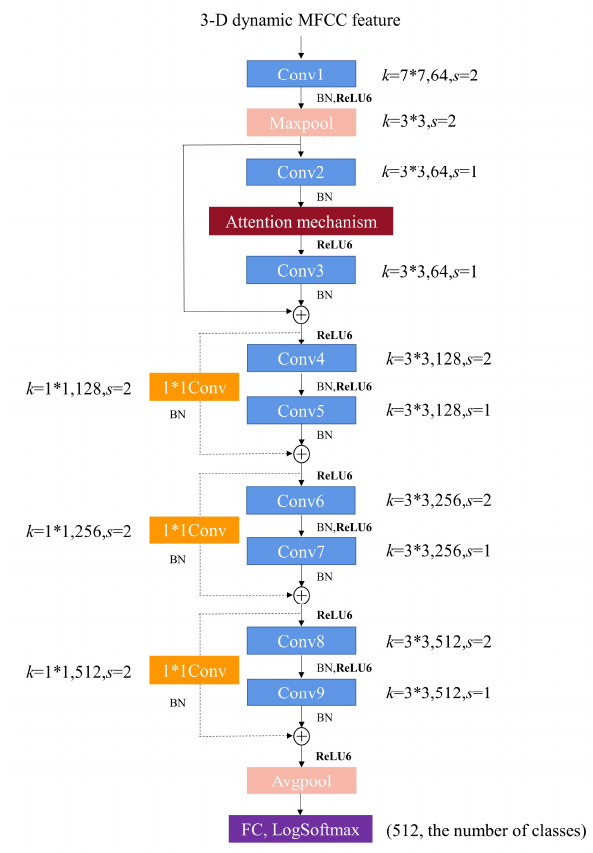
Figure 2. The proposed model, LW-SEResNet10.